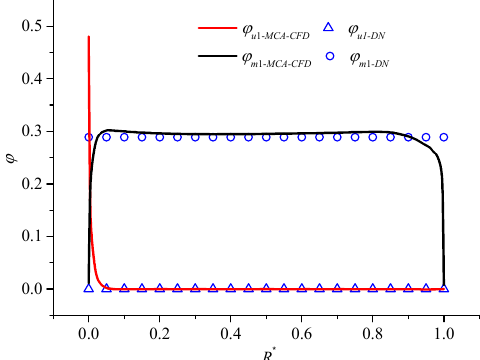
Figure 16. Distribution of impeller inlet velocity coefficient.